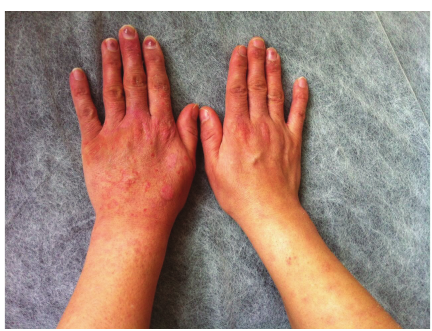
Figure 11: Improvement of skin lesions after 3